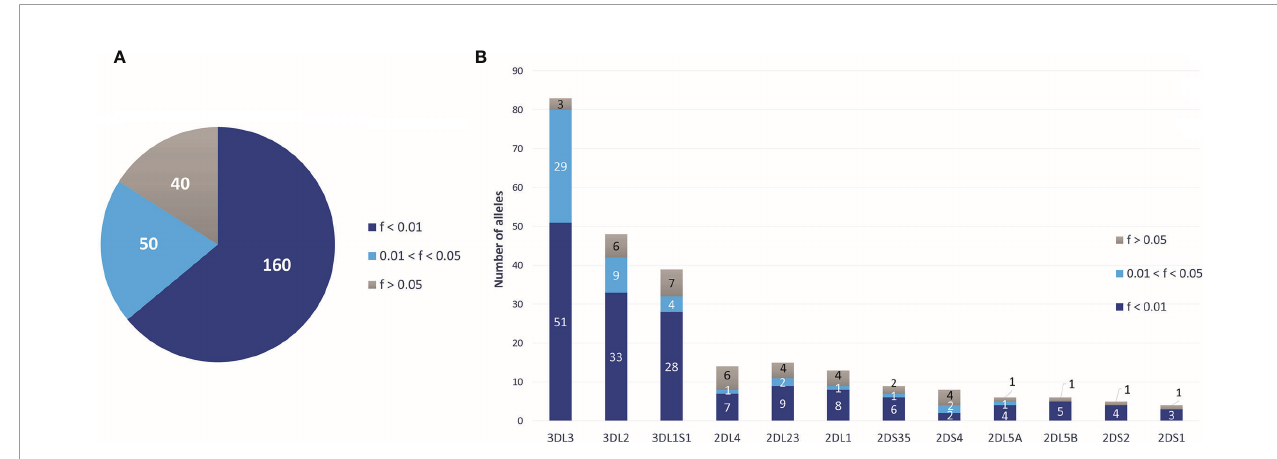
FIGURE 3 | Overview of the KIR allelic diversity in European-Americans. (A) Total number of KIR alleles at 5-digit resolution observed in 2,130 European Americans and strati fi ed by frequency. (B) Number of alleles observed for each gene (5-digit resolution), strati fi ed by frequency.